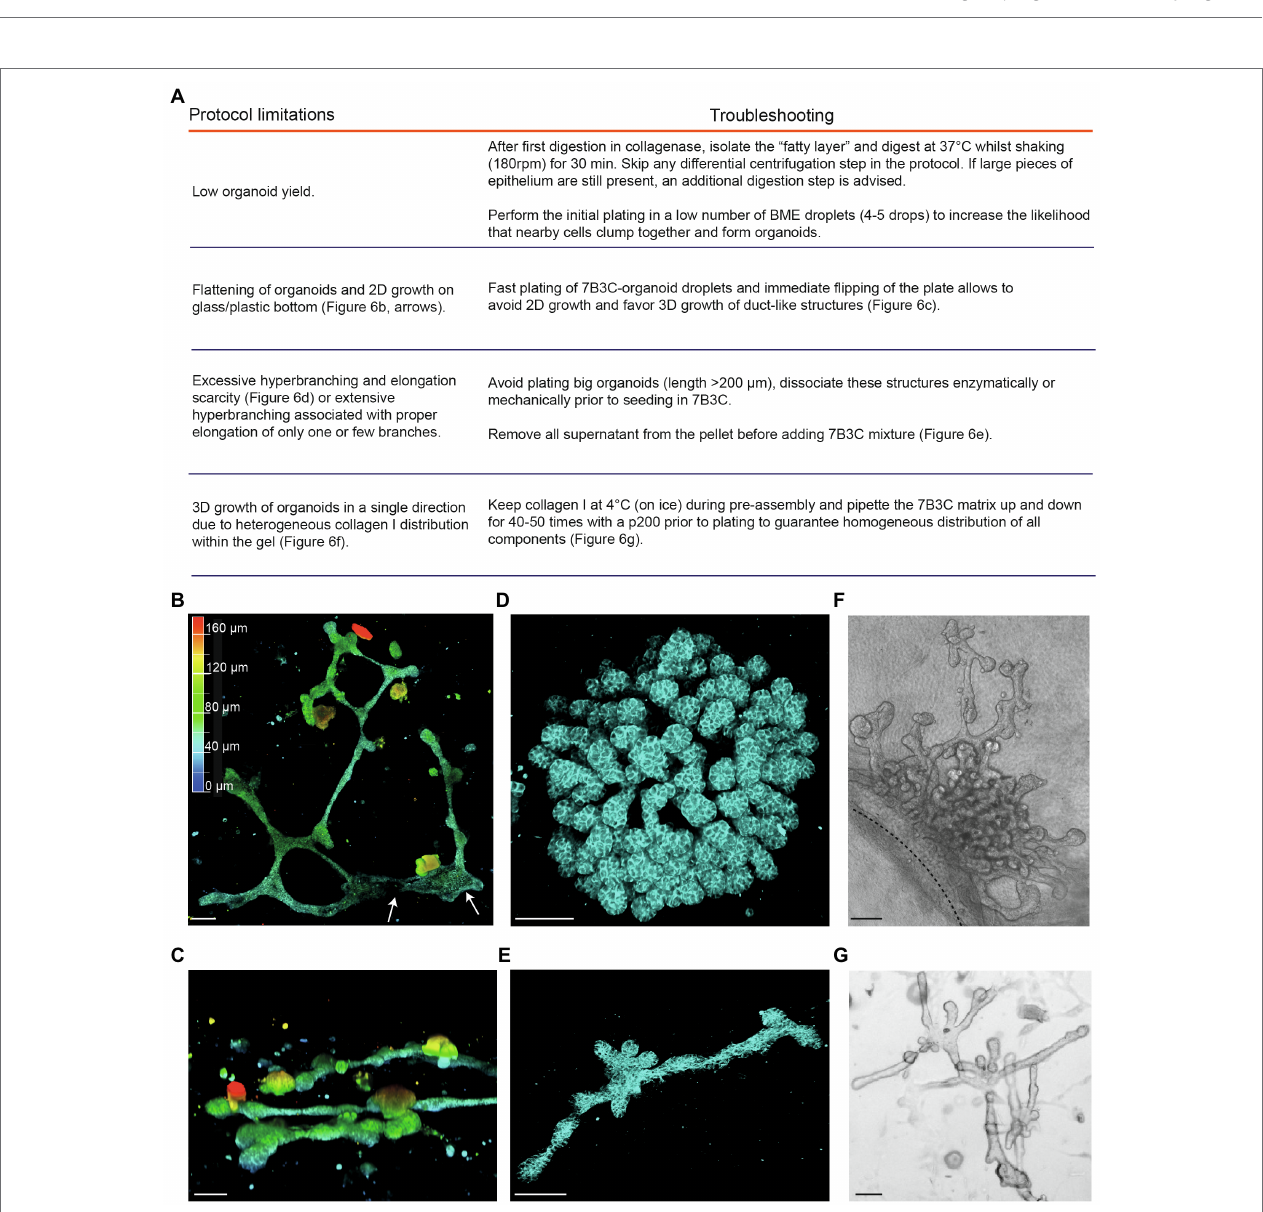
FIGURE 6 | Limitations and troubleshooting of the mammary organoid branching protocol. (A) Overview of common pitfalls during the mammary branching organoid protocol. (B) Example of flattened organoid (3D rendering) on the bottom of the cell culture dish, top view. White arrows indicate 2D sheets of cells; colors indicate depth coding. (C) Confocal image of ductal organoid structures showing 3D growth, side view. (D,E) Confocal images (3D rendering) of a hyperbranched organoid with lack of branch elongation (D) and an elongated organoid after careful removal of all supernatant from the organoid pellet before adding the 7B3C mixture (E) . Cdh1-CFP signal in cyan. (F) Brightfield image showing local and uni-directional branching of an organoid with a large core area due to inhomogeneous collagen I distribution within the gel. (G) Brightfield image of a branched and elongated organoid obtained after thorough mixing of the 7B3C matrix prior to plating. Scale bars represent 100 μ